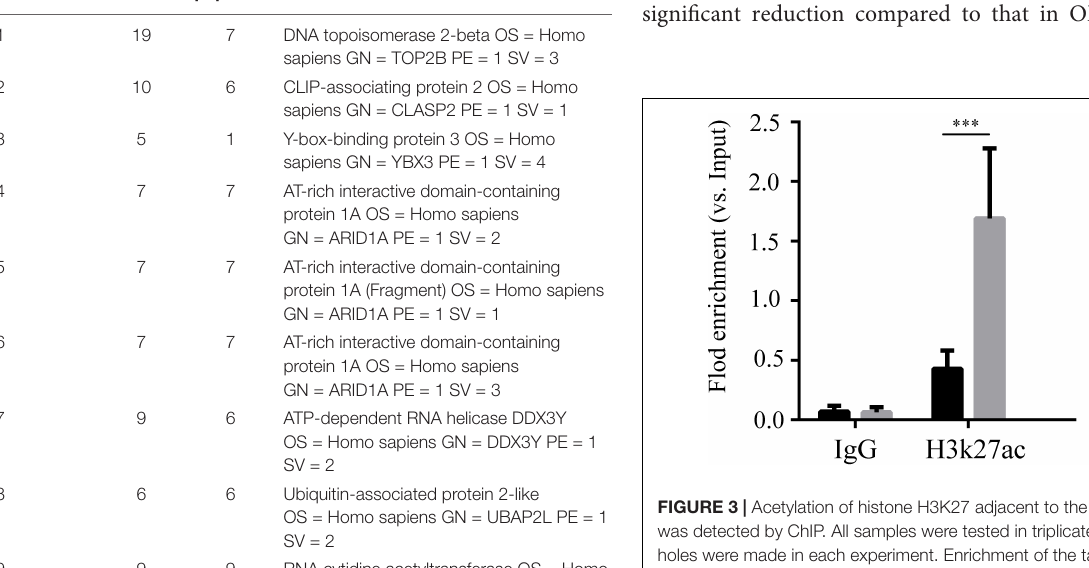
TABLE 3 | Top fifteen differential proteins were listed below. Sequential Peptides Unique Group description number peptides